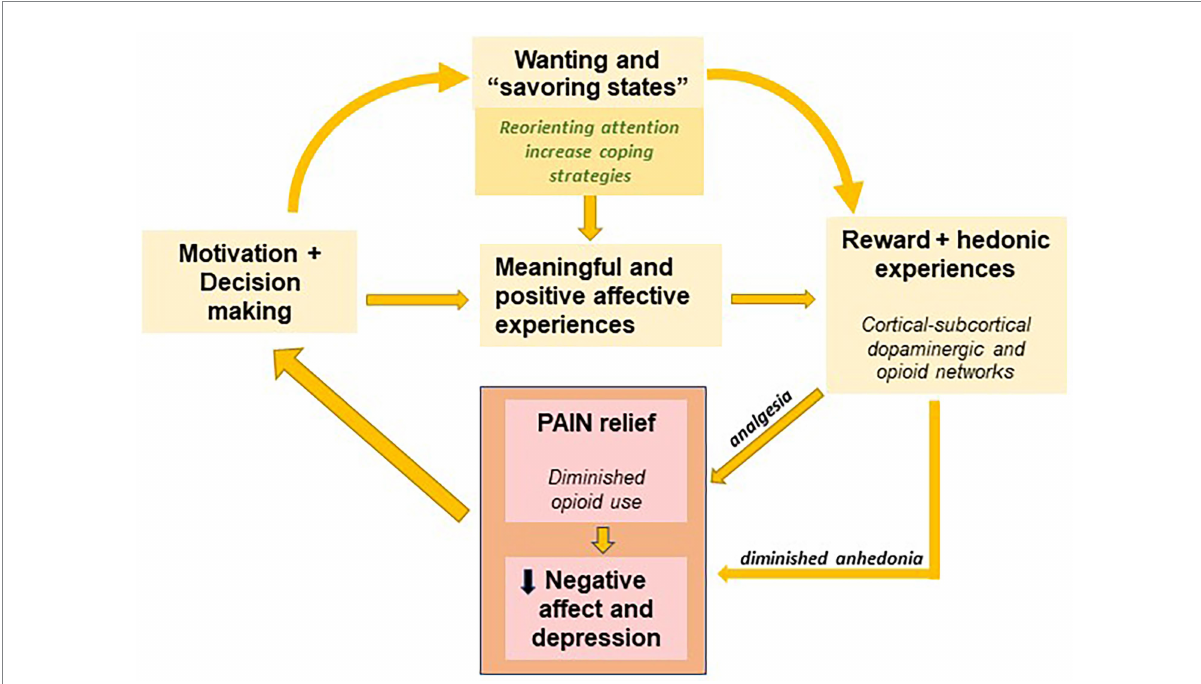
FIGURE 2 Scheme of the interrelation of the different factors affecting the capacity to experience pleasurable experiences in endometriosis (adapted following the model presented in Garland, 2020). Yellow boxes illustrate the motivational processes involved in increasing hedonic and meaningful experiences. The increase in reward and positive hedonic experiences might decrease negative affective states that characterize endometriosis ( pink boxes ), diminishing anhedonia and in turn indirectly potentiating